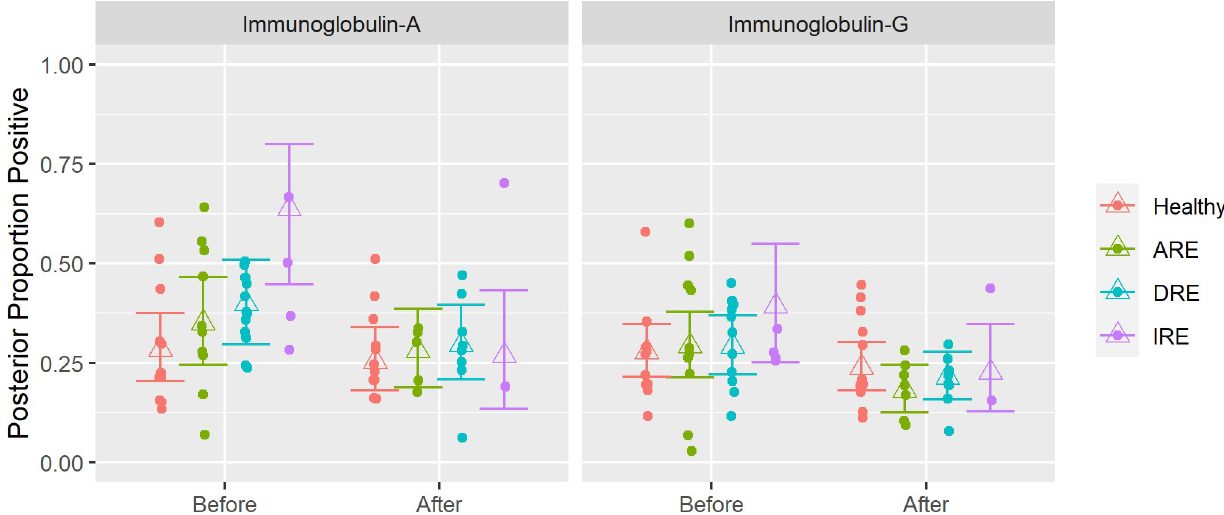
Fig 2. The posterior predicted relative abundances of immunoglobulin A (IgA) and immunoglobulin (IgG) from healthy dogs and dogs with chronic enteropathy (CE).